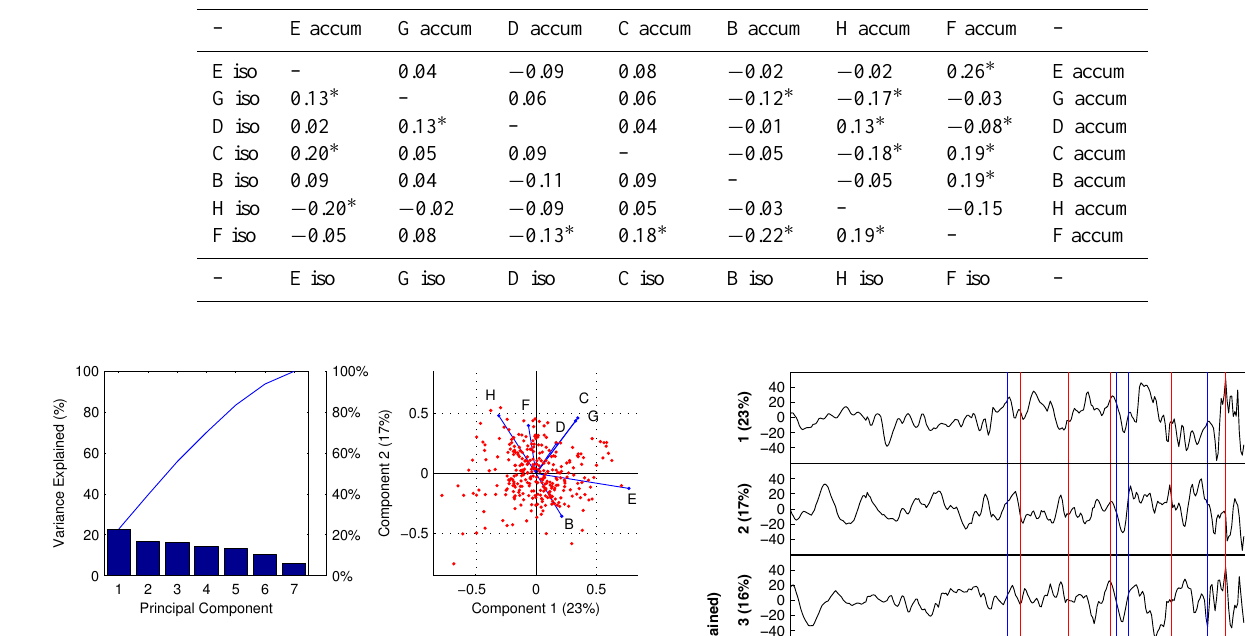
Figure 4. Left panel: principal component analysis of the Siple δ Drecords.Right)Bi-plotofcomponent1vs.component Figure 4. Left)PrincipalComponentAnalysisoftheSipleDomeshallowicecore Dome shallow ice core δ D records. Right panel: biplot of compo- 2. nent 1 vs. component 2.